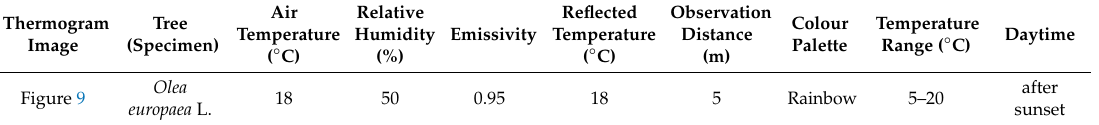
Figure 9. Thermogram of the Olea europaea L. tree recorded in passive mode at 5:50 p.m., 15 min after sunset. (Spot’s size out of scale for better visualization). Table 5. The ambient conditions and parameters assumed for recording thermogram of Olea europaea L. Thermogram Image